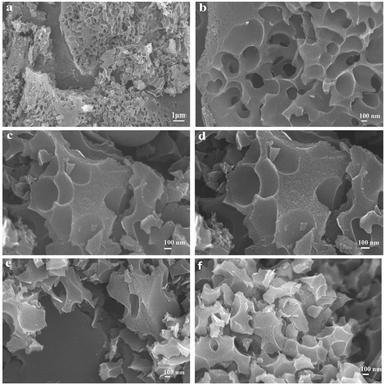
SEM images of FDAC1 (a and b), FDAC2 (c and d), and FDAC3 (e and f).